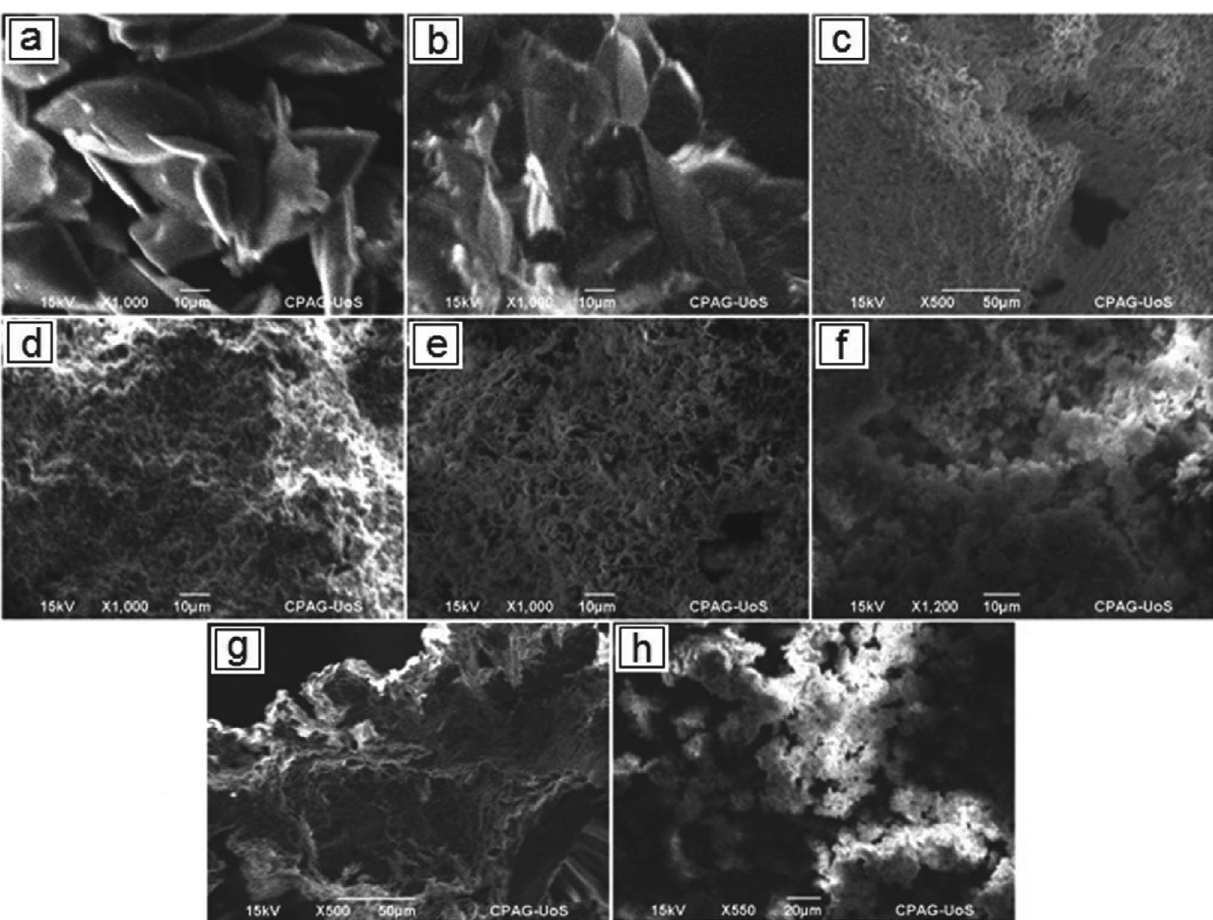
Figure 7 . SEM Images of (a) p -HOB (b) o -HOB (c) P p HOBND (d) P p HOBPD (e) P p HOBCy (f) P o HOBPD (g) P o HOBP and (h) Schiff base report- ed 34 conditions as